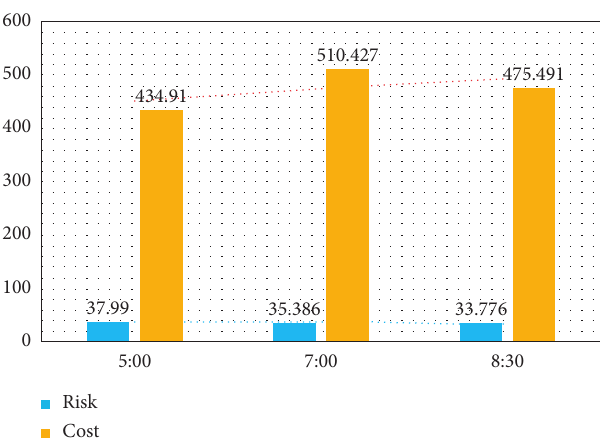
Figure 13: Comparison of transportation risk and cost in different time frames.